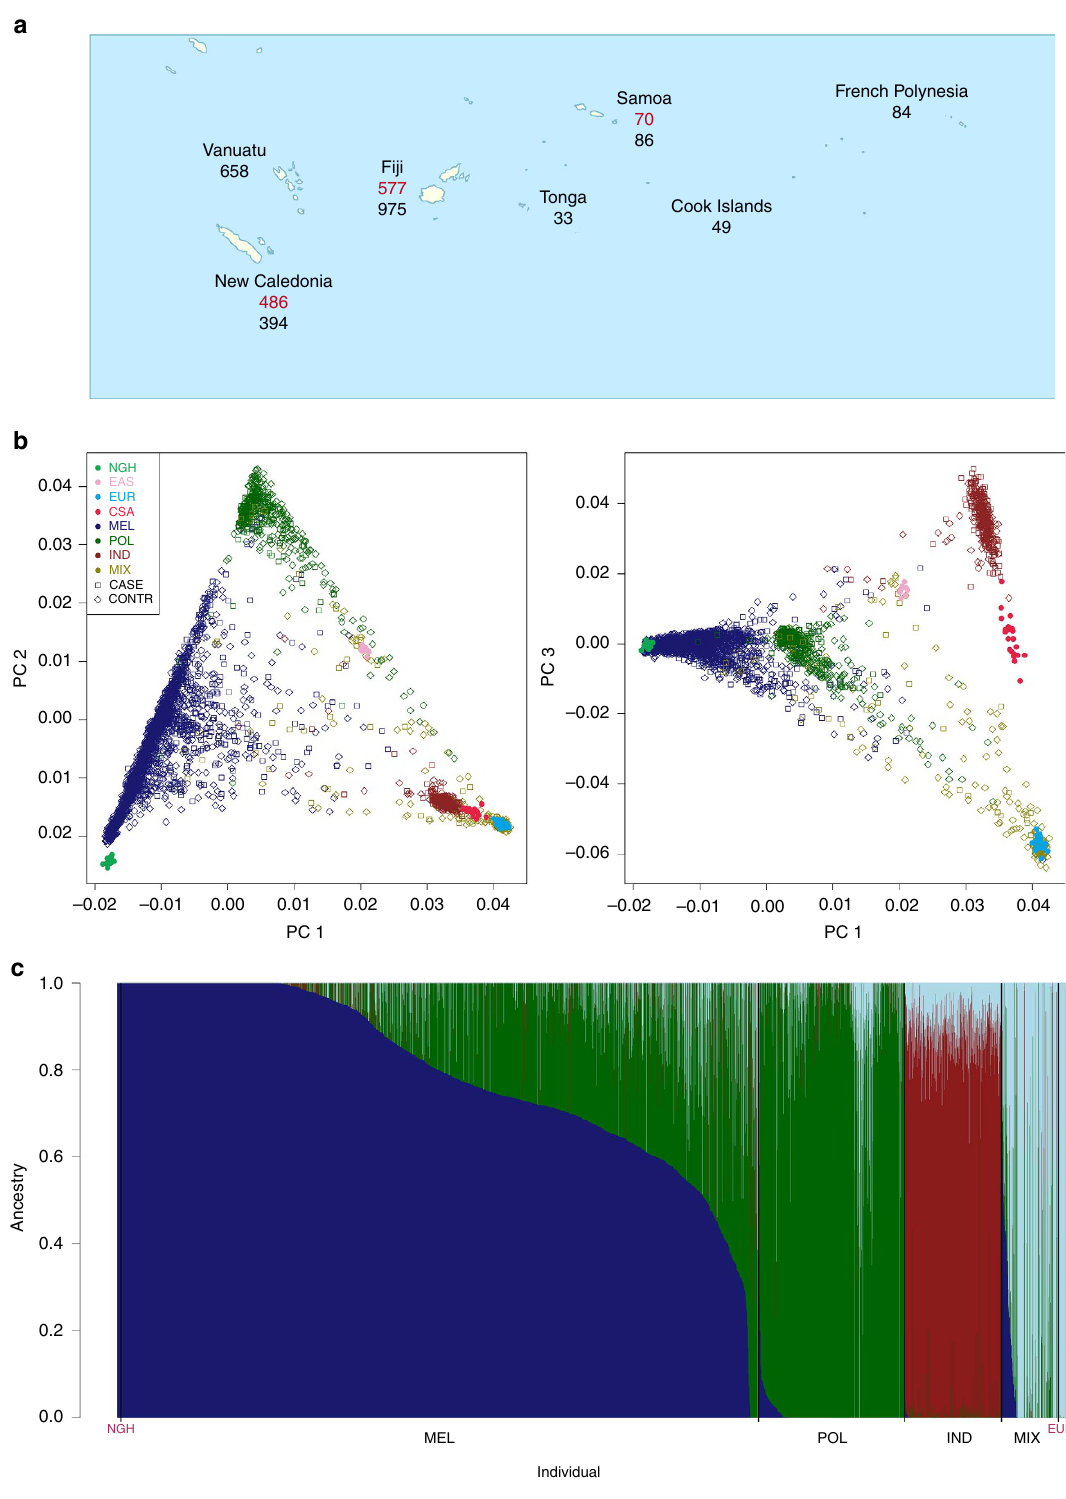
Figure 1 | Oceanian study population. ( a ) Approximate location where genotyped cases (red) and controls (black) were sampled. ( b ) Projection of the samples on to the first and second (left) and first and third (right) principal components (PCs) of genetic variation coloured by self-reported ancestry (MEL, Melanesians; POL, Polynesian; IND, Fijian Indian; MIX, Mixed and other) with cases indicated by empty squares and controls by empty diamonds. Selected samples from the Human Genome Diversity Project Panel (NGH, Papuan; EAS, South East Asian; EUR, European; CSA, Central South Asian) are superimposed for comparison and indicated by filled circles. ( c ) Estimates of admixture proportions from four source populations grouped by self-reported ancestry, with selected samples of Papuan and European ancestry shown at the far left and right, respectively, for